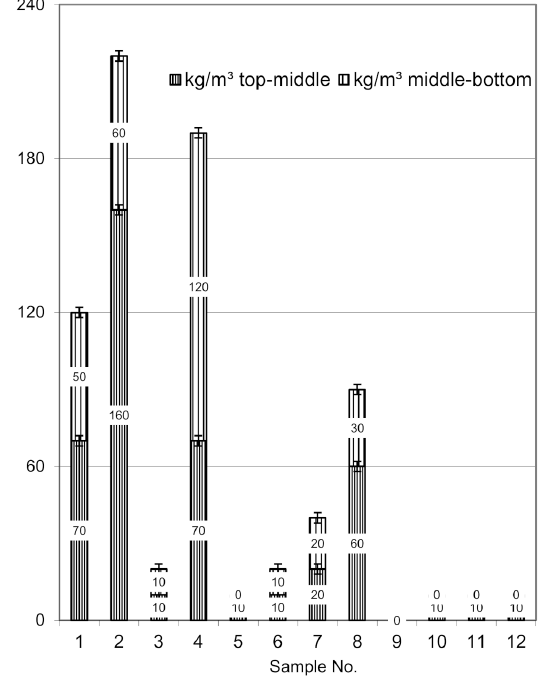
Figure 3. Density difference between the top and middle and middle and bottom of the column for the fractionation test. The measurement angle is 90 ◦ .